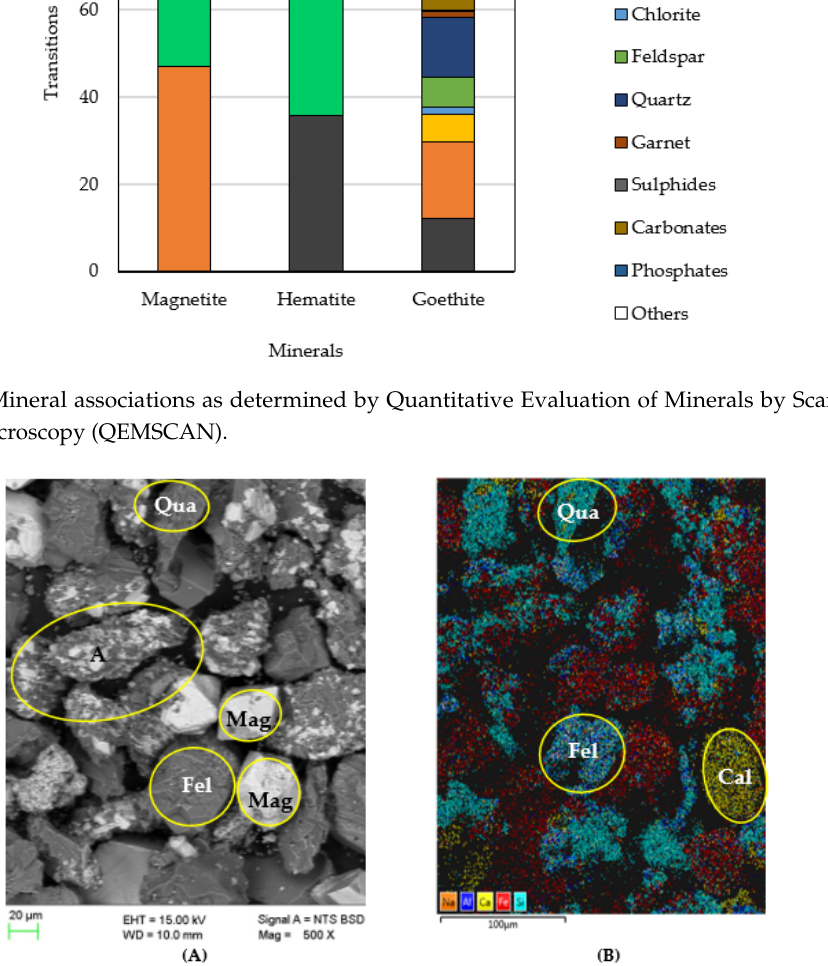
Figure 5. SEM BSE image ( A ) and chemical map image ( B ) of the ore feed. Mag = magnetite; Qua = quartz; Fel = feldspar; Cal = calcite; A = A composite of magnetite, quartz, and feldspar.